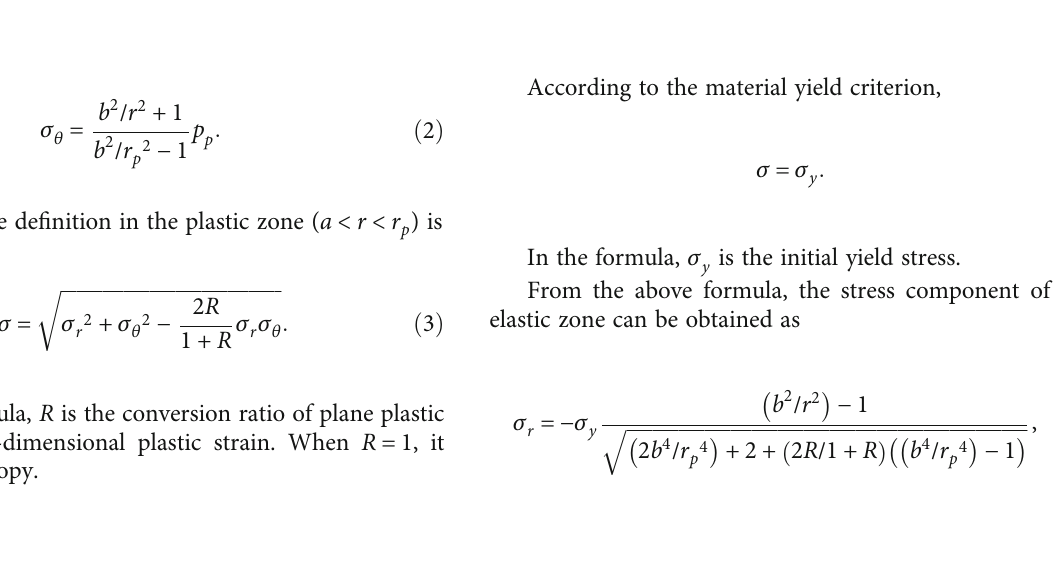
Figure 8: Von Mises stress and tangential residual stress distribution cloud diagram under di ff erent